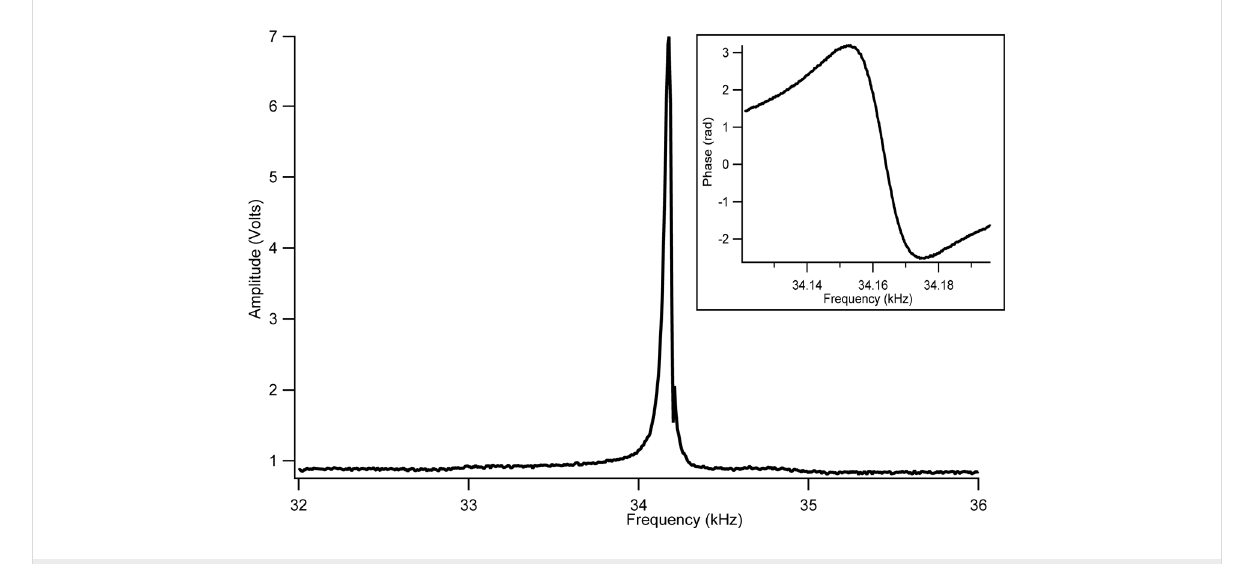
Figure 5: An example resonance response of AFM probes used in the